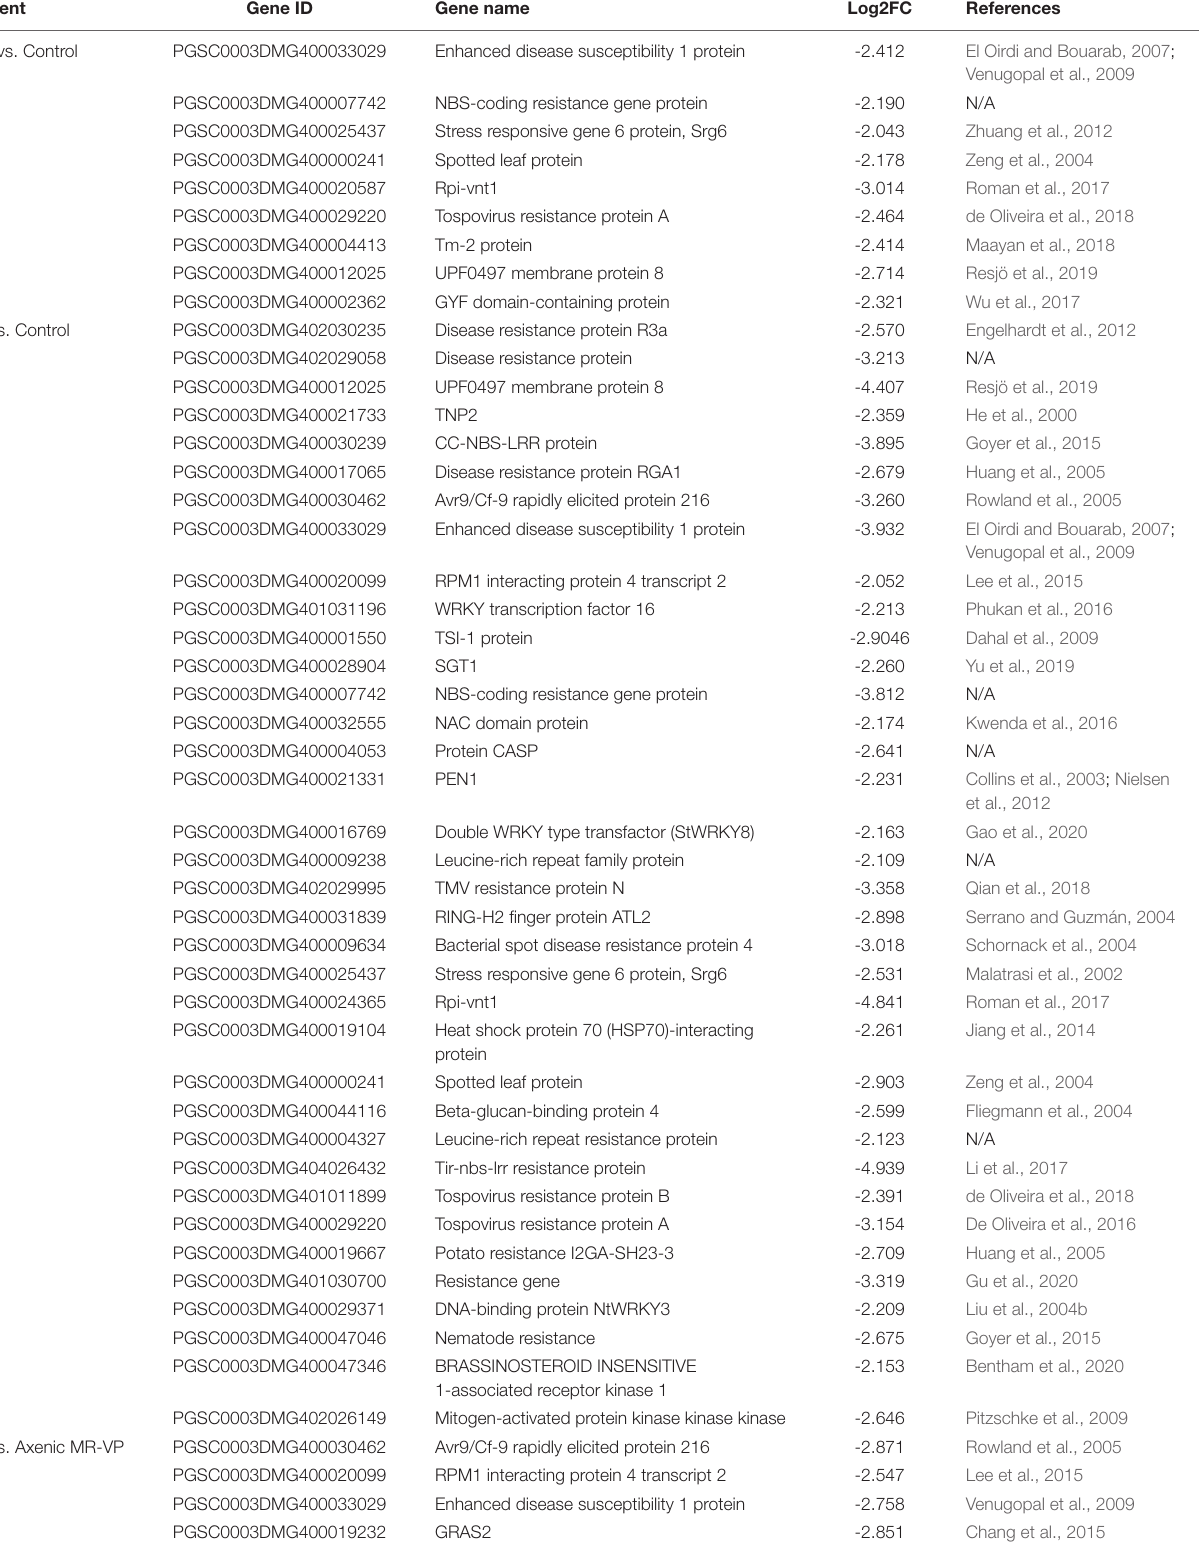
TABLE 4 | Downregulated genes from PGSC genome annotations directly involved in or related to plant defense and stress responses identified post-BVC exposure.